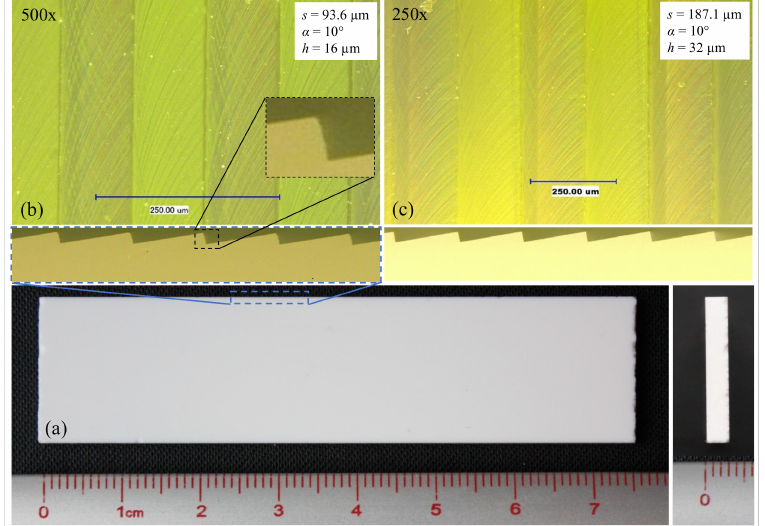
Figure 9. Example of fabricated ATR samples: ( a ) overview, ( b ) surface detail for h = 16 µ m, and ( c ) surface detail for h = 32 µ